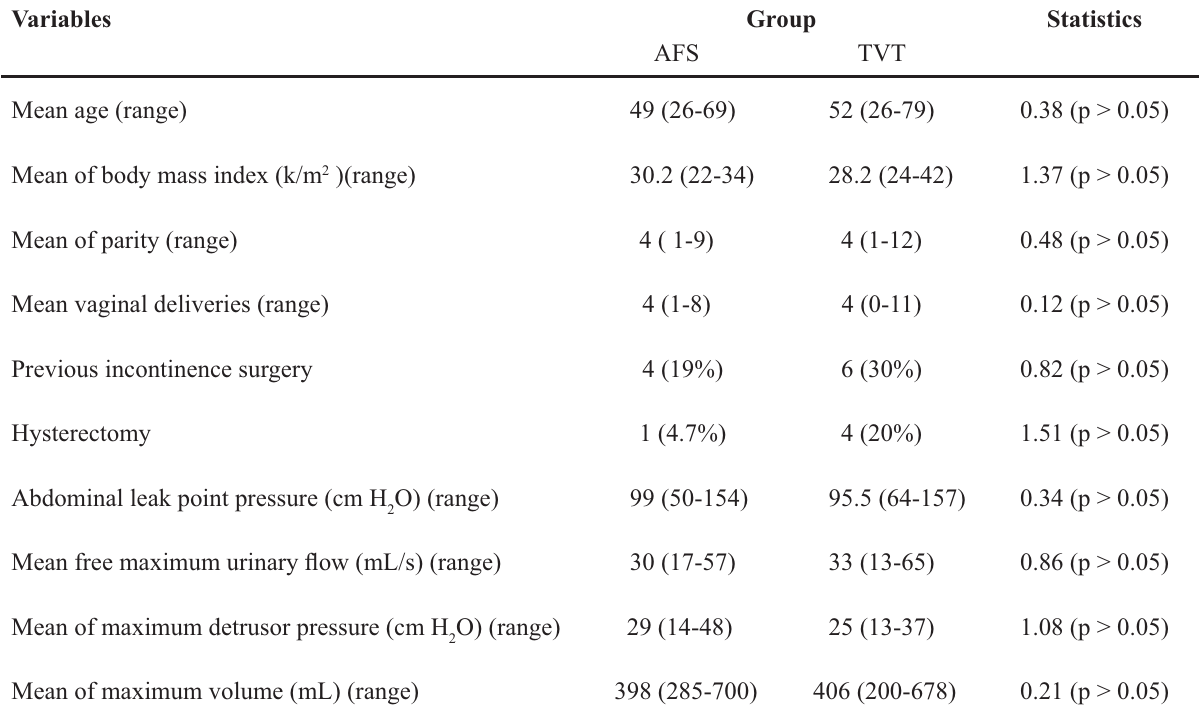
Table 1 – Preoperative clinical and urodynamics characteristics of the patients submitted to autologous fascial sling (AFS) (n = 21) and tension-free vaginal tape (TVT) (n = 20). Variables Group Statistics AFS TVT Mean age (range)